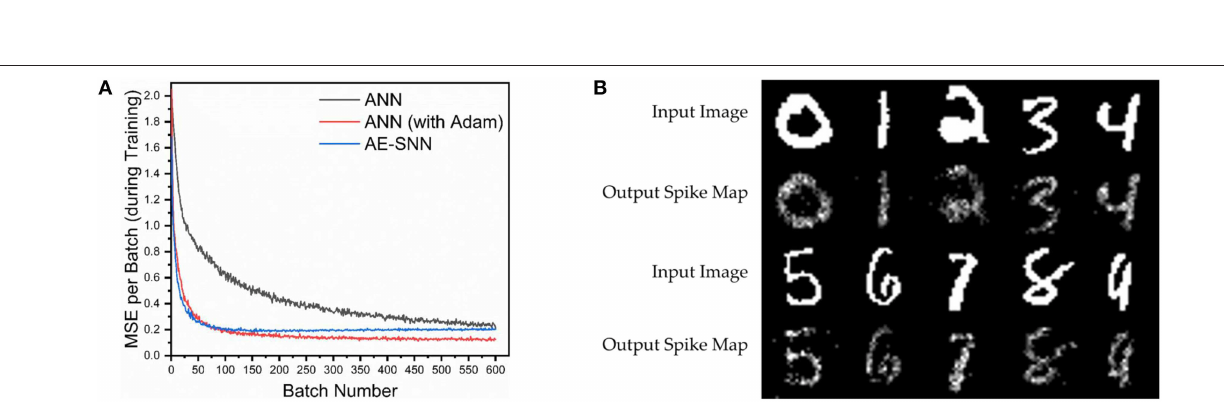
Frontiers in Neuroscience |